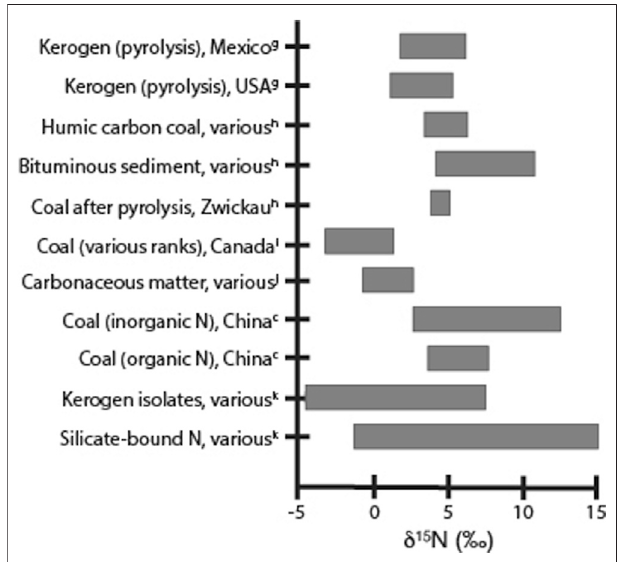
FIGURE 5 | Ranges of measured δ 15 N values for kerogen, coal, and silicate-bound nitrogen samples, as referred to in the text. Values shown are from g Peters et al. 1981, h Stiehl and Lehmann 1980; i Whiticar 1996, j Ader et al. 2006, c Xie et al. 2021, and k Stüeken et al. 2017; for analytical and sample details, please refer to the original